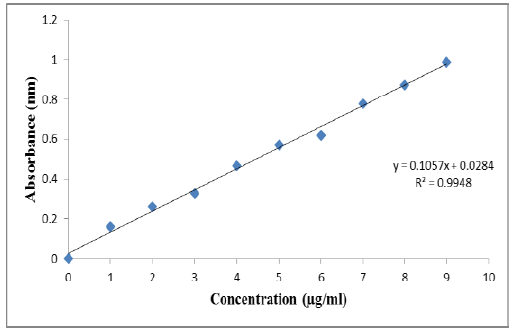
Figure (6) Calibration curve of rebamipide in ethanol Fourier transform infrared spectroscopy (FTIR) The FTIR spectrum of pure rebamipide figure (7) was compared to the reference FTIR spectrum of rebamipide reported in Japanese